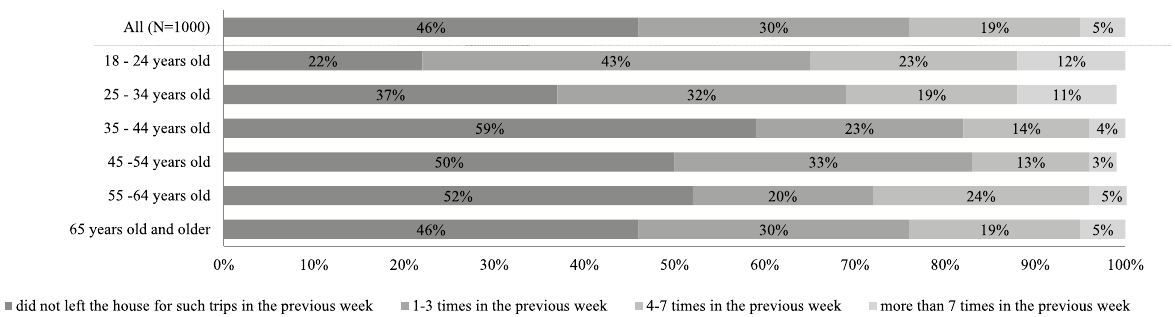
Fig. 4 Frequency of the number of leisure trips and/ or errands in the week previous to the survey week depending on age group a respondent belongs